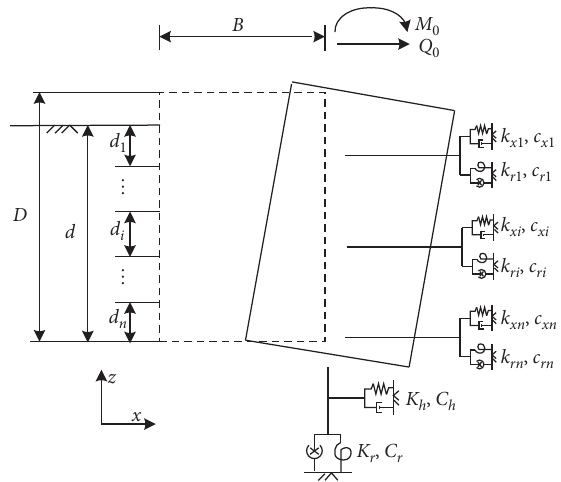
Figure 1: Dynamic Winkler model for the lateral vibration of the